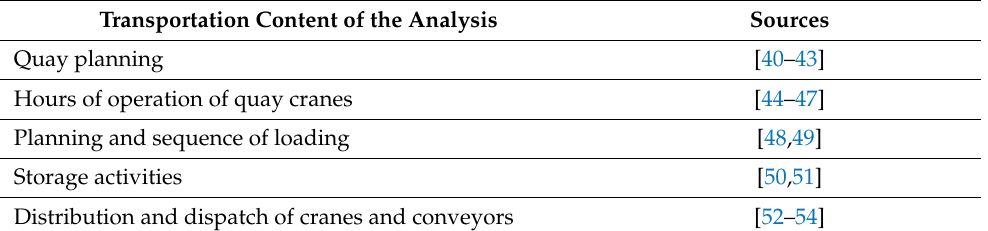
Table 1. Different perspectives by different analyses of container port